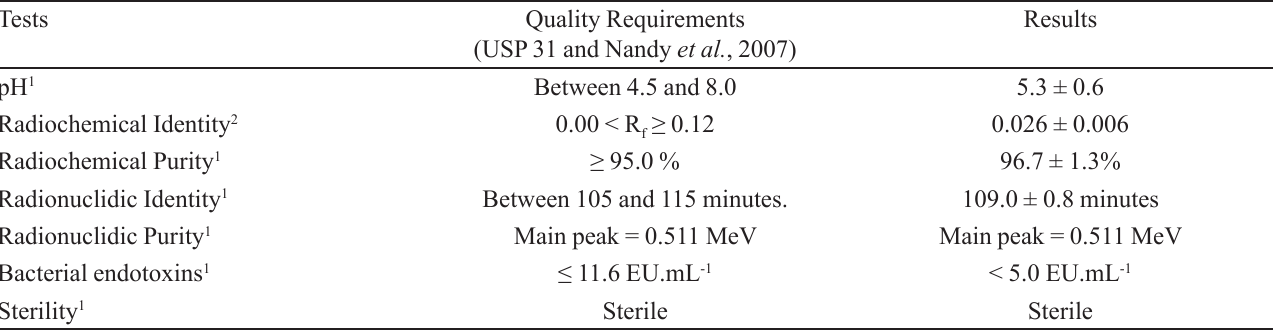
TABLE I - Results obtained after testing Na 18 F microbiological, physical-chemical and biological properties ( 1 USP 31; 2 Nandy et al. , 2007)